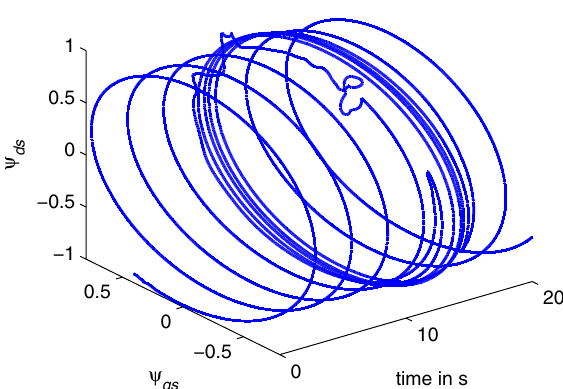
Fig. 5 3-D plot of flux linkages w.r.t time for a three-phase fault at bus 4